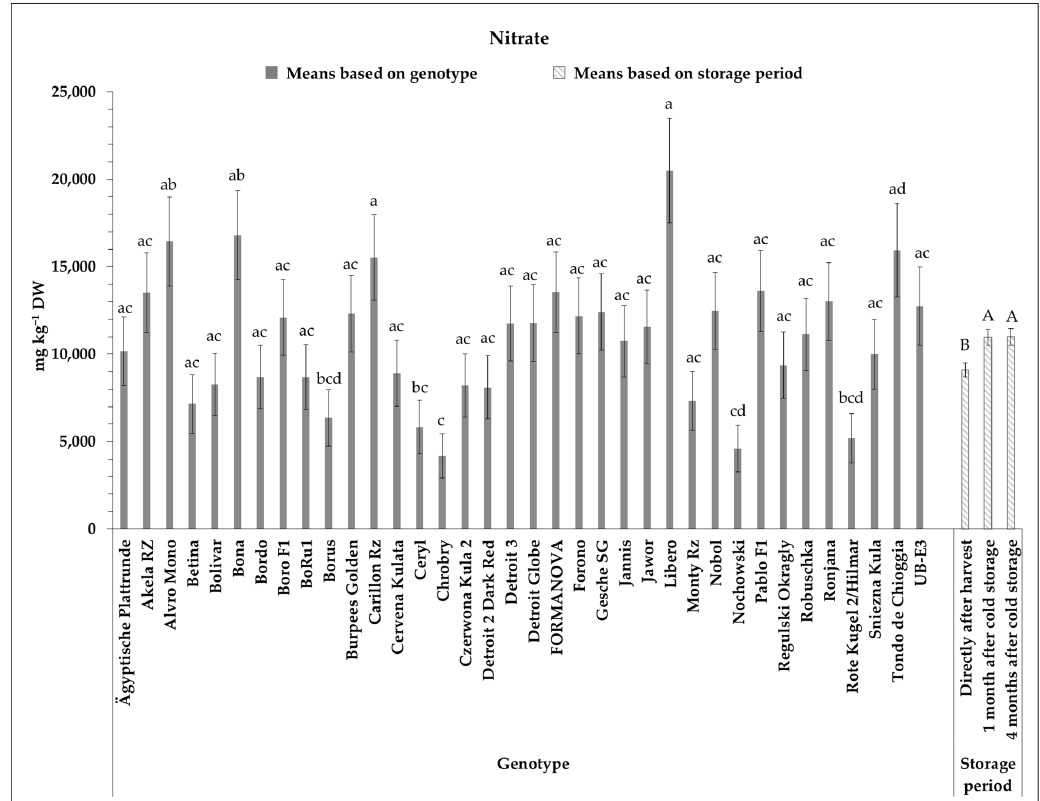
Figure 1. Median values of nitrate content (mg kg − 1 DW) of 36 beetroot genotypes grown at the research station Kleinhohenheim within the years 2017 and 2018, based on genotype and storage period. Results represent the median values ± asymptotic standard error. Medians covered by at least one identical lower-case letter did not differ significantly between genotypes at experiment-wise Type 1 error α = 0.05. Medians covered by at least one identical upper-case letter did not differ significantly between storage periods at experiment-wise Type 1 error α = 0.05.